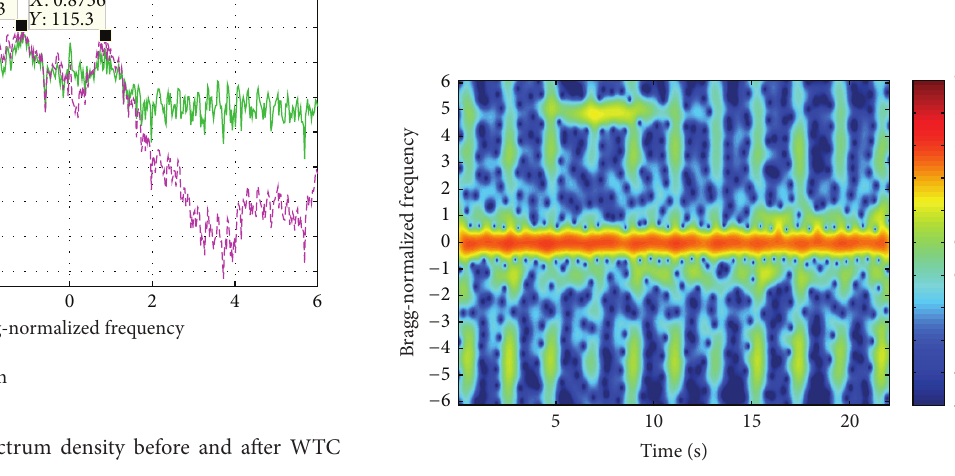
Figure 16: Time-frequency spectrogram of sum signal.